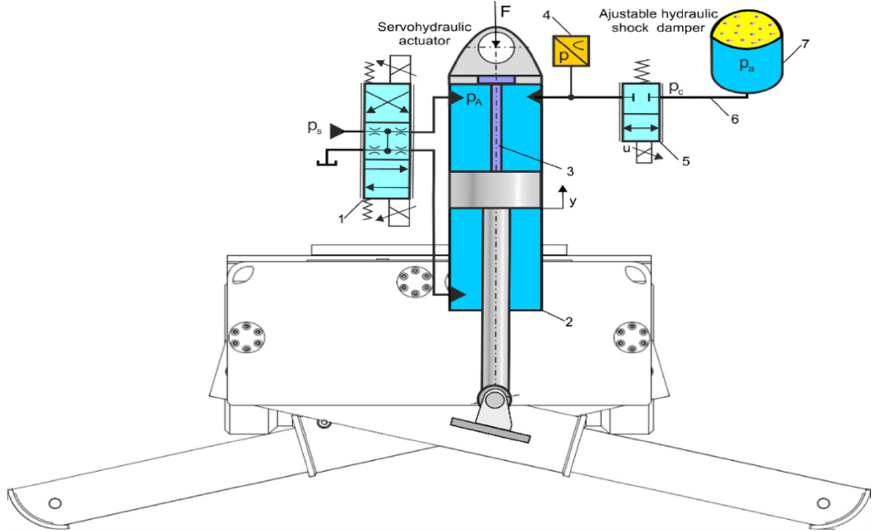
Figure 4. Schematic diagram of an SHA-HSD system: 1: proportional directional control valve, 2: hydraulic lift actuator, 3: magnetostrictive linear position transducer, 4: pressure transducer, 5: proportional damping valve, 6: connecting tube, 7: hydropneumatic accumulator.